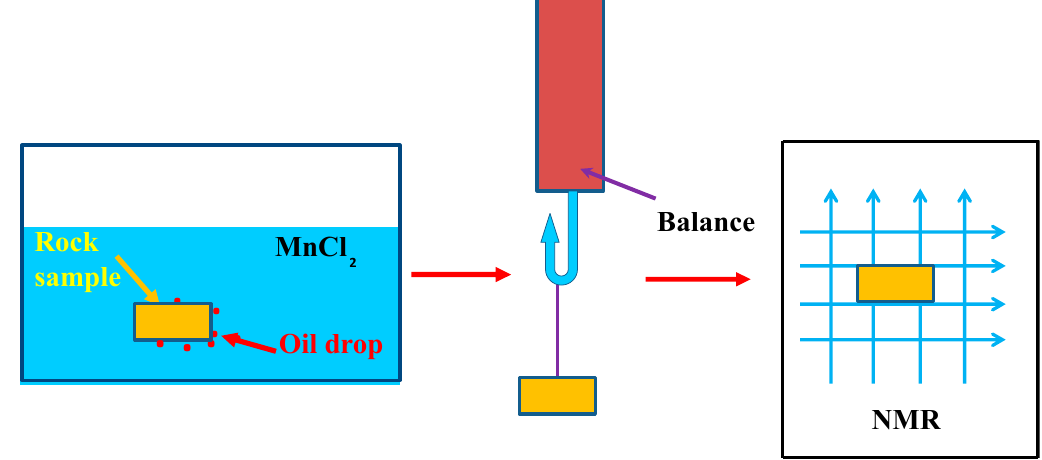
Figure 2. The schematic diagram of the experimental procedure.